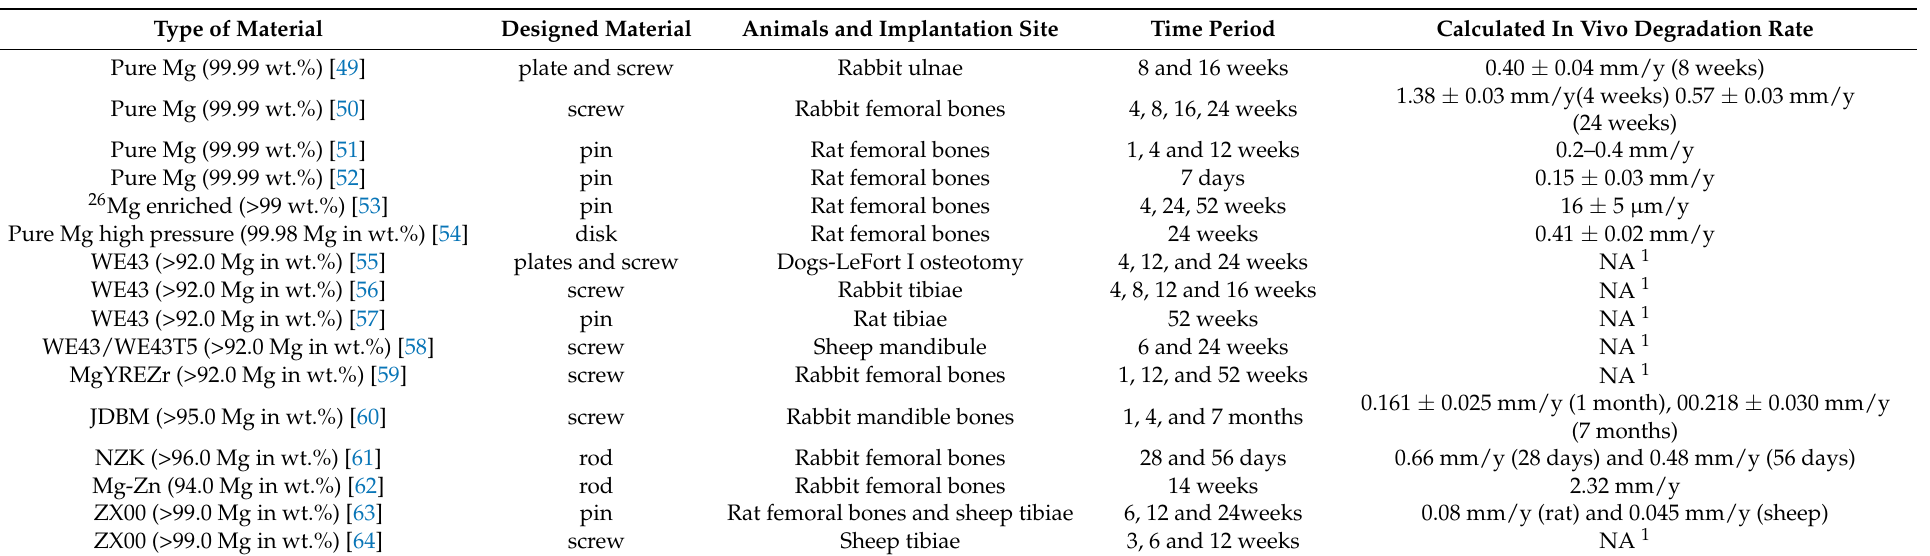
Table 1. Representative pre-clinical studies of Mg-based